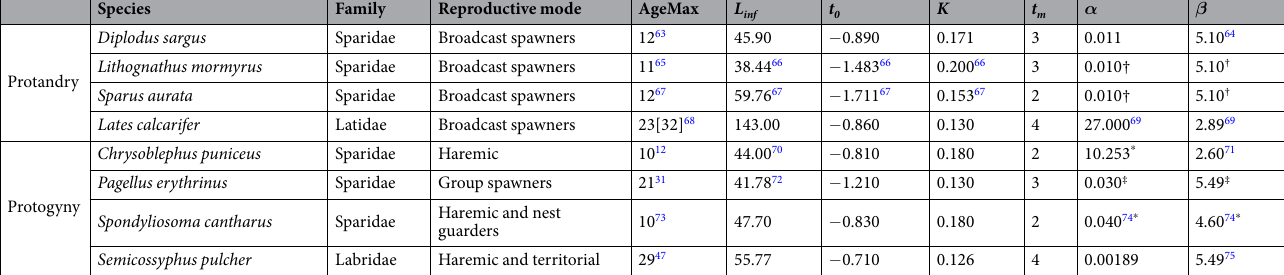
PG = 753.00 ± 213.41; PA = 603.50 ± 120.87; t = − 1.22, df = 6, p = 0.280; Fig. 2). Similarly, no significant dif- ference was detected in generation length (mean ± sd: PG = 10.24 ± 5.02; PA = 7.88 ± 1.94; t = − 0.87, df = 6, p = 0.416). Indeed, the linear model returned protogyny (t = − 7.280; p < 0.001) as the main factor reducing the size effective ratio N e / N , which allows to control for the variance in population abundance estimates ( N ). As all the species under study are iteroparous, N b (effective number of breeders per breeding cycle) was also calculated and found to be significantly lower in protogynous than in protandrous species (mean ± sd: PG = 155.98 ± 20.91; PA = 348.20 ± 129.91; W = 16, p = 0.0286; Fig. 2). The linear model returned protogyny (t = − 6.179, p = 0.003) as the main factor reducing N b / N (again, to control for the variance in population abun- dance estimates, N ), with maximum length as a covariate, which significantly increased this size effective ratio (t = 2.954, p = 0.042). The analysis of the N b / N e ratio revealed no influence of the mating system (t = − 2.074; p = 0.093), but a sig- nificant effect of maximum length (t = 4.886; p = 0.004). The male-first sex-changer L. calcarifer showed a ratio larger than 1 ( N b / N e = 1.059), meaning that in this species the number of breeders per year is actually higher than the overall effective population size (Fig. 2). It was also possible to analyse ¯ k , and annual V k and N b for each sex. Graphically (Fig. 3) it is easy to visualize the reproductive strategy for an individual when it reproduces as a different sex during its lifetime, changing from the first sex (male in protandry and female in protogyny) to the second sex (female in protandry and male in protogyny). Individuals belonging to protandrous species have higher annual ¯ k (mean ± sd: ♀ = 7.17 ± 2.26; ♂ = 0.55 ± 0.06; = 5.06, df = 6, p = 0.002) and V k ( ♀ = 22.70 ± 14.80; ♂ = 2.24 ± 0.75; t = 5.06, df = 6, p = 0.002) when they are older and larger (second sex, female, Fig. 3a). For this latter stage of life (the female phase), in the population there are fewer breeders per year than for the male phase ( N b ♀ = 124.20 ± 52.39; N b ♂ = 299.00 ± 87.71; t = − 3.561, df = 6, p = 0.012). A mirrored situation applies to protogynous species, and in this case the magnitude is even stronger (Fig. 3b): larger males second sex) have much higher annual ¯ k ( ♂ = 17.82 ± 4.04; ♀ = 0.51 ± 0.09;